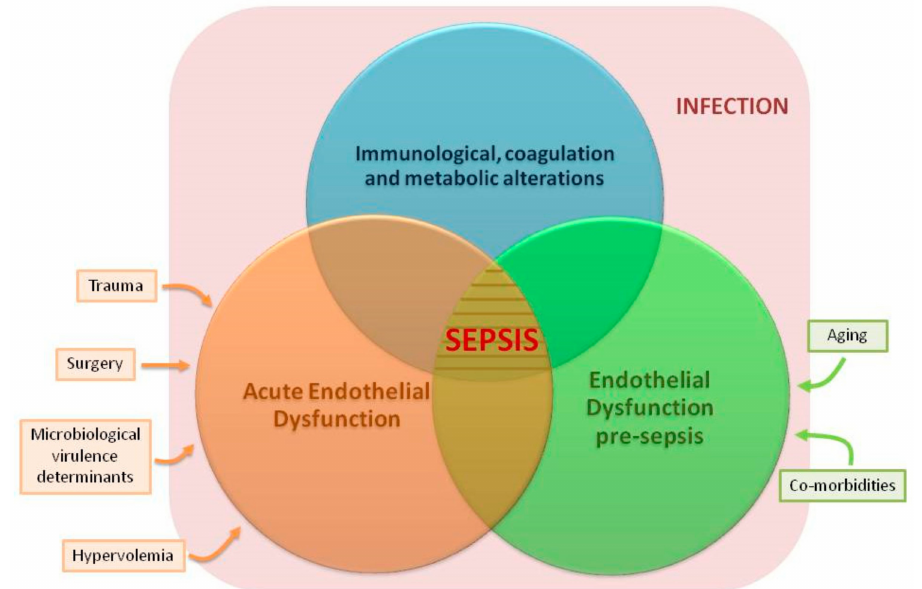
Figure 3. Potentially synergistic factors contributing to sepsis. Blue circle: immunological, coagulation or metabolic alterations previous to sepsis or induced by sepsis. Green circle: chronic endothelial dysfunction (ED) pre-sepsis caused by aging and chronic diseases. Orange circle: acute ED induced by sepsis secondary to microbial aggression, to the dysfunctional host response to infection, hypervolemia, trauma, surgery, and/or to other acute insults facilitating